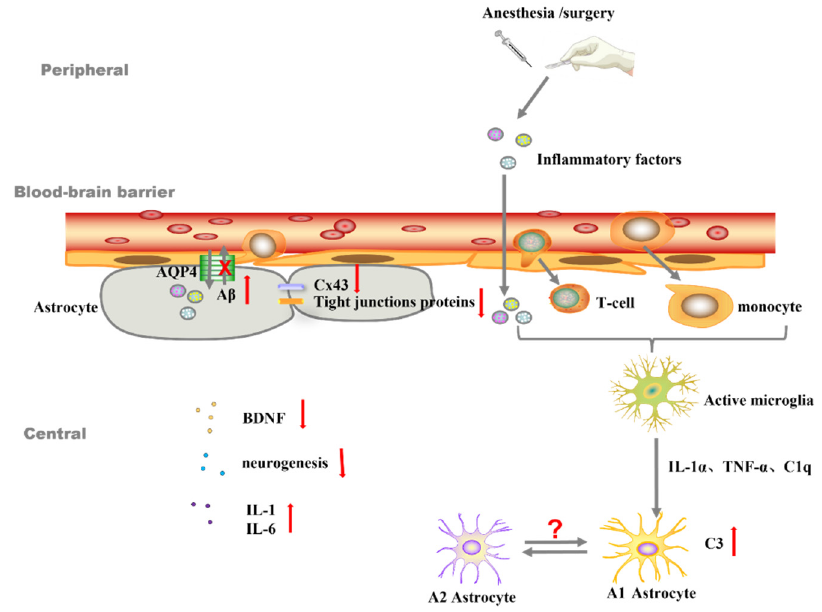
Figure 1. The role of astrocytes in neuroinflammation and blood–brain barrier. IL-1 α : interleukin-1 α . TNF- α : tumor necrosis factor α . C1q: component 1q. C3: Component C3. A β : β -amyloid. Cx43: Gap junctions-connexin 43. BDNF: Brain-derived neurotrophic factor.